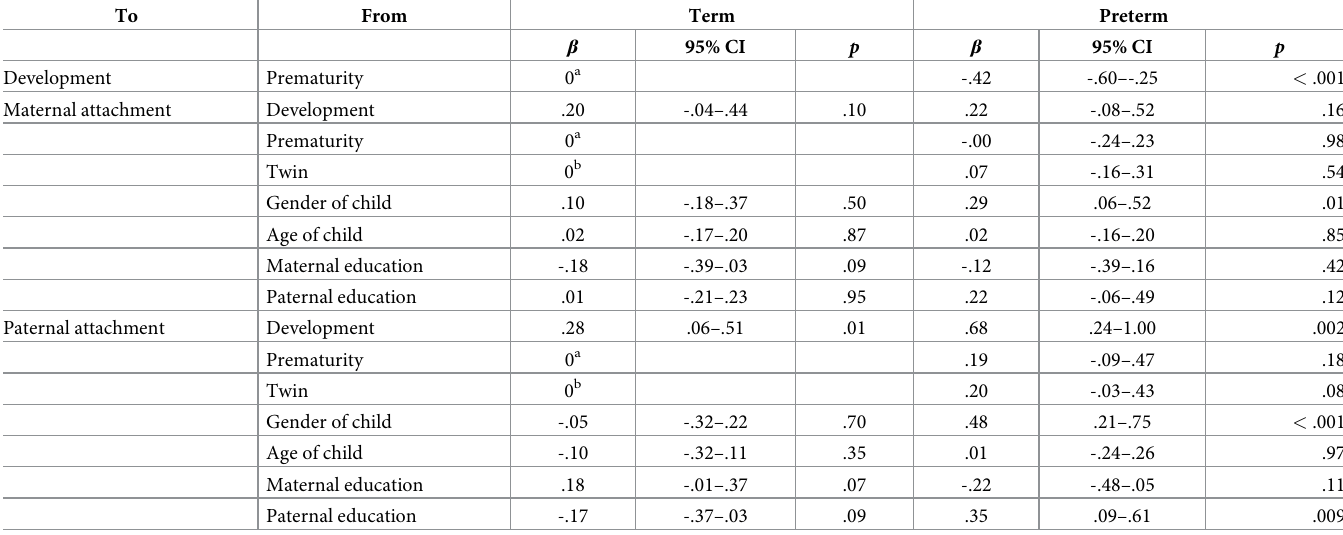
Table 2. Standardized path coefficients of unrestrained base model.